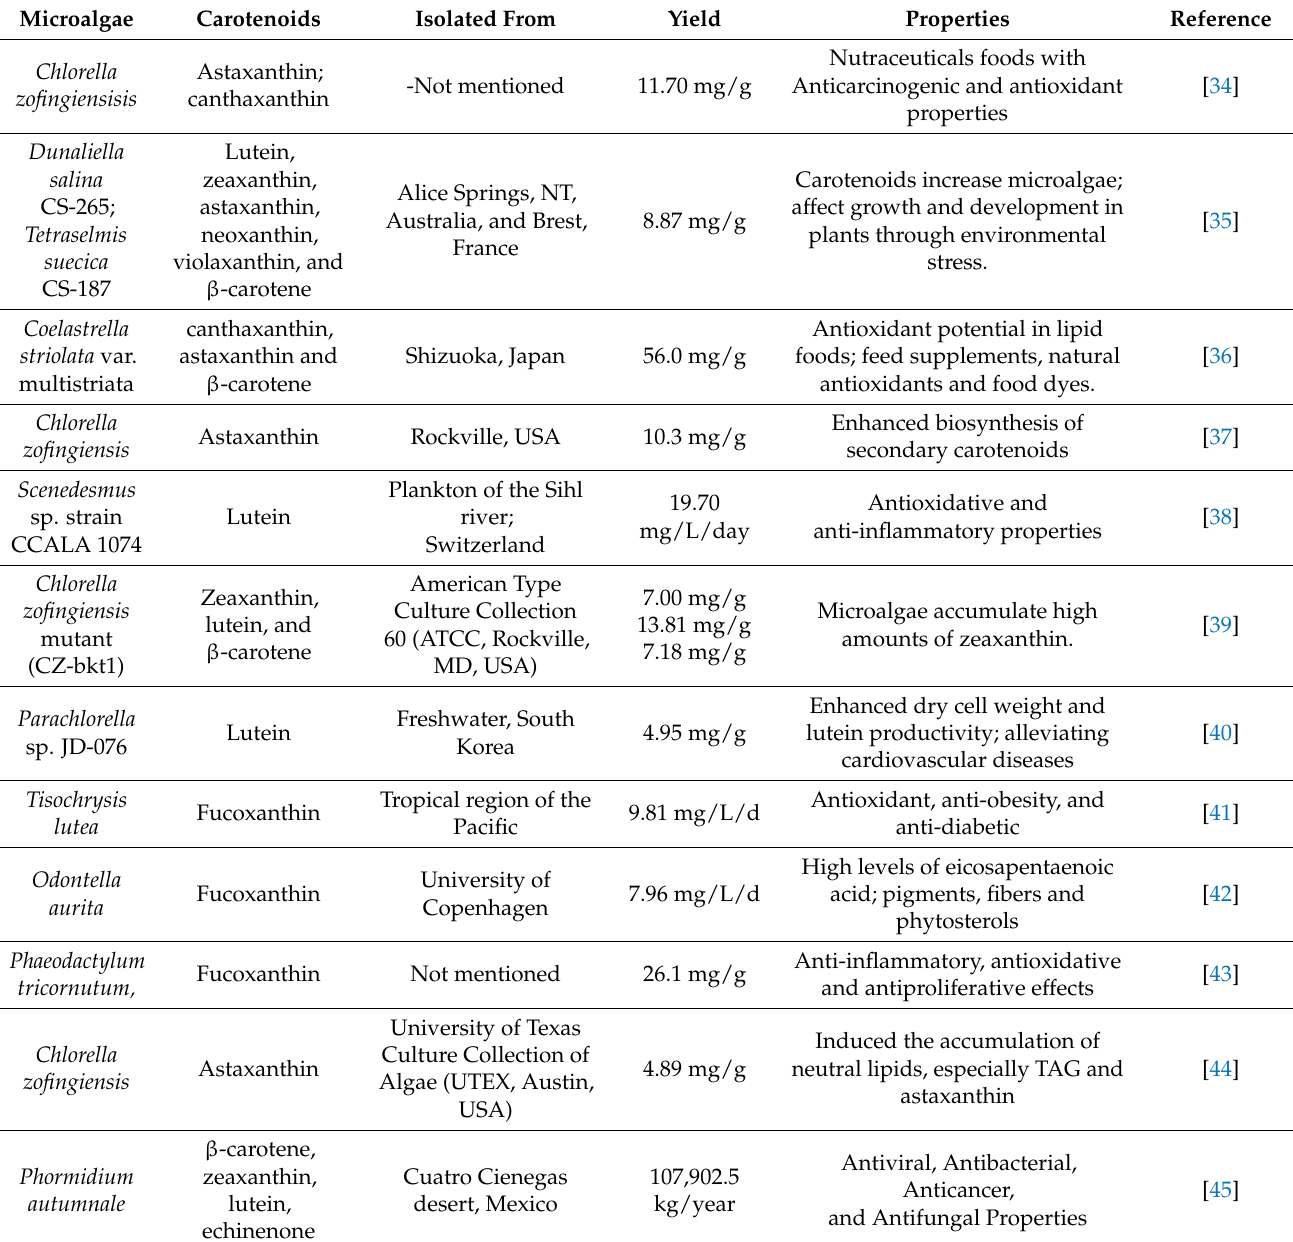
Table 2. Production of different types of carotenoids from microalgae and their